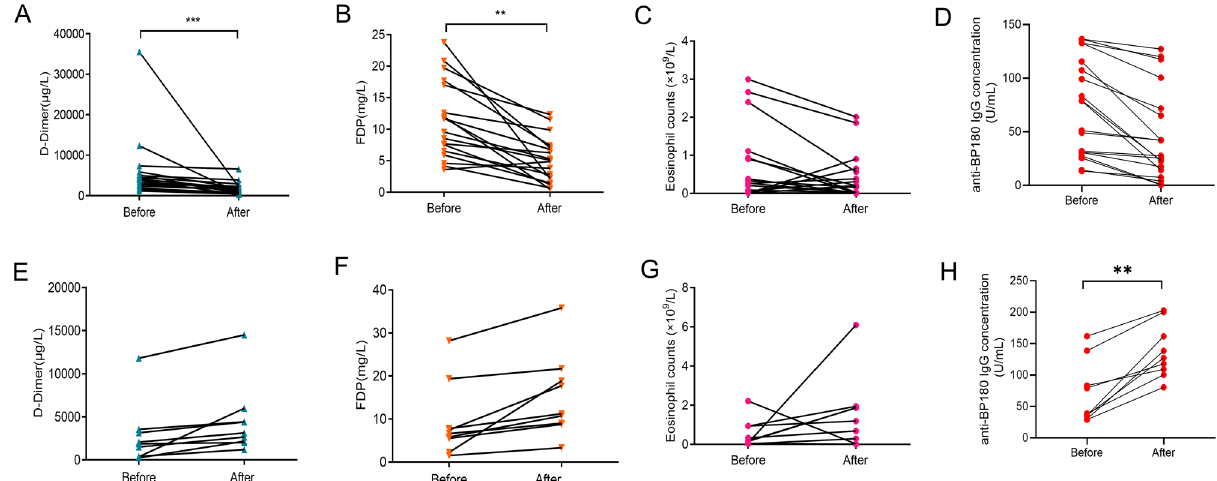
Figure 4. D-dimer, FDP, eosinophil counts, and anti-BP180 IgG concentrations in BP patients with treatment-effective and -resistant BP. Plasma D-dimer levels ( A ), FDP levels ( B ), eosinophil counts ( C ), and anti-BP180 IgG concentration ( D ) in 19 patients with treatment-effective BP were evaluated before and after immunosuppressive therapy. Marked reductions in these markers were observed after complete remission. Plasma D-dimer levels ( E ), FDP levels ( F ), eosinophil counts ( G ), and anti-BP180 IgG concentration ( H ) in nine patients with treatment-resistant BP were evaluated before and after immunosuppressive therapy. A slight elevation in these markers was observed without relief. (** P < 0.01; *** P <